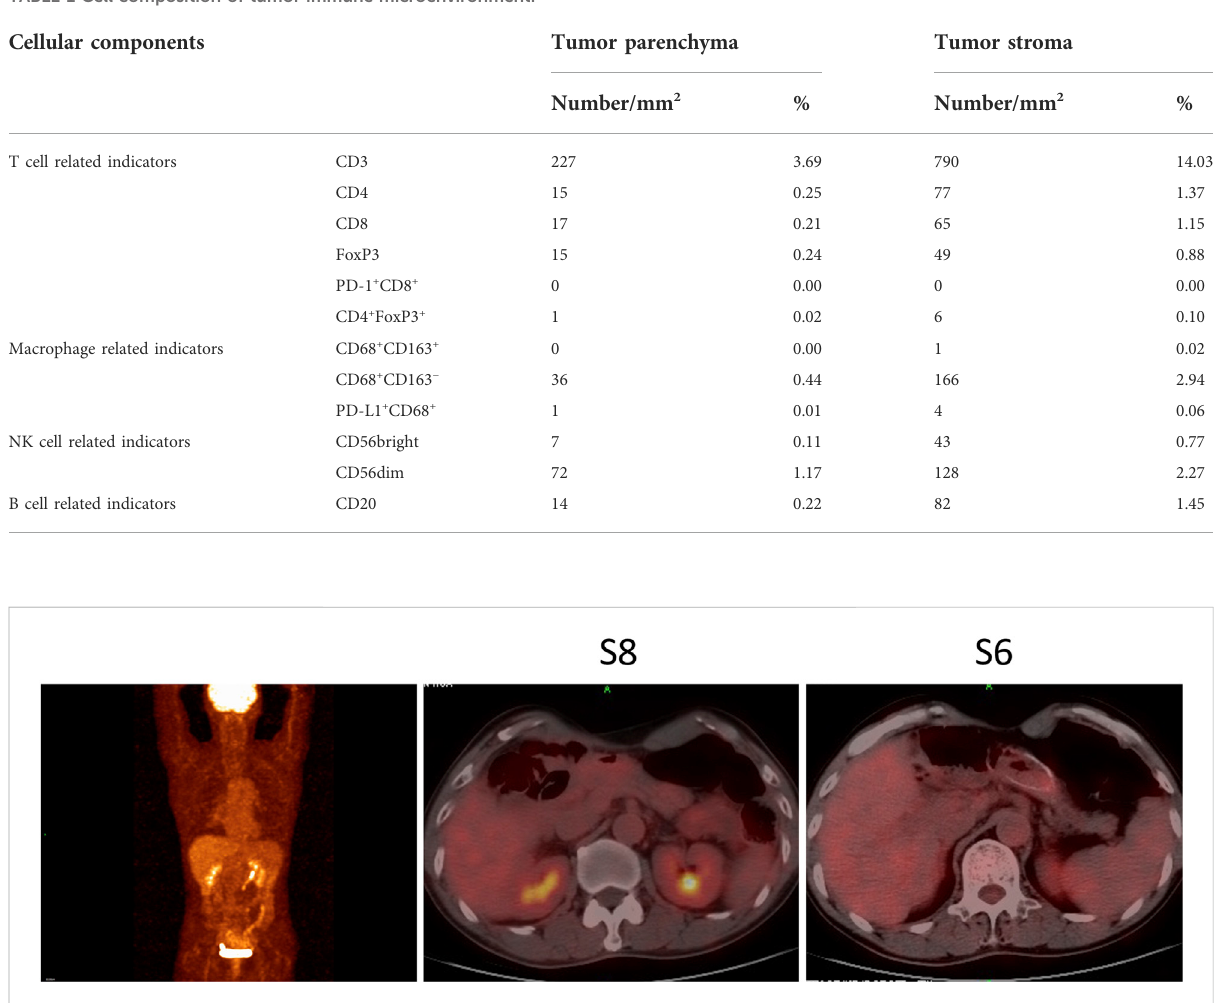
TABLE 1 Cell composition of tumor immune